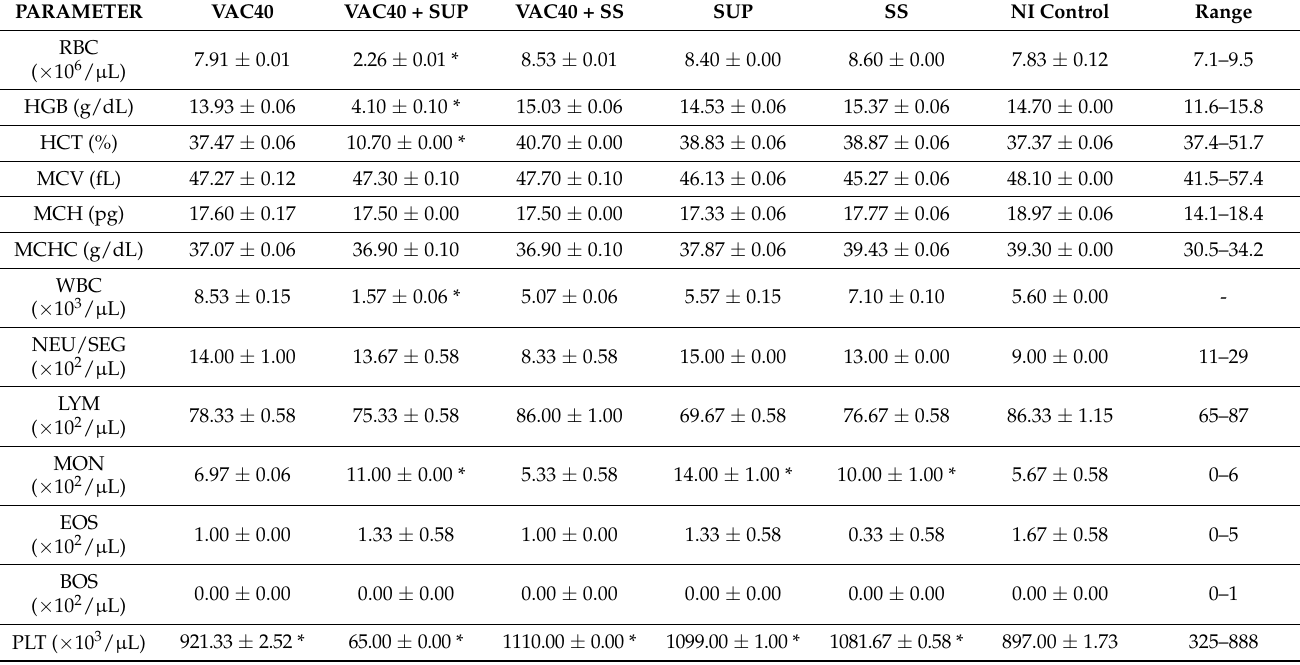
Table 4. Hematological parameters for female BALB/c mice immunized with 4 × 10 9 virus particles doses supplemented with selenium 28 days